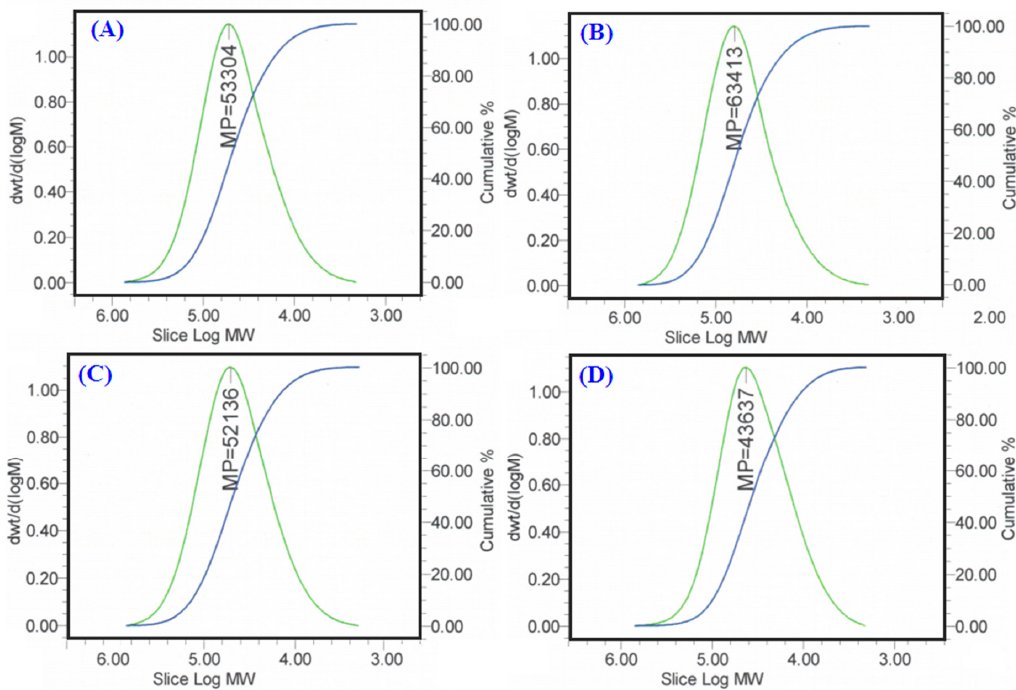
Figure 9. Gel permeation chromatography (GPC) chromatographs of ( A ) neat PA6, ( B ) PA6-BABT/SA 10 , ( C ) PA6-BABT/SA 20 , and ( D ) PA6-BABT/SA 30 . Table 3. Intrinsic viscosity and molecular weights of neat PA6 and PA6-BABT/SA copolymers. Intrinsic Viscosity M n Sample Intrinsic dL/g Sample